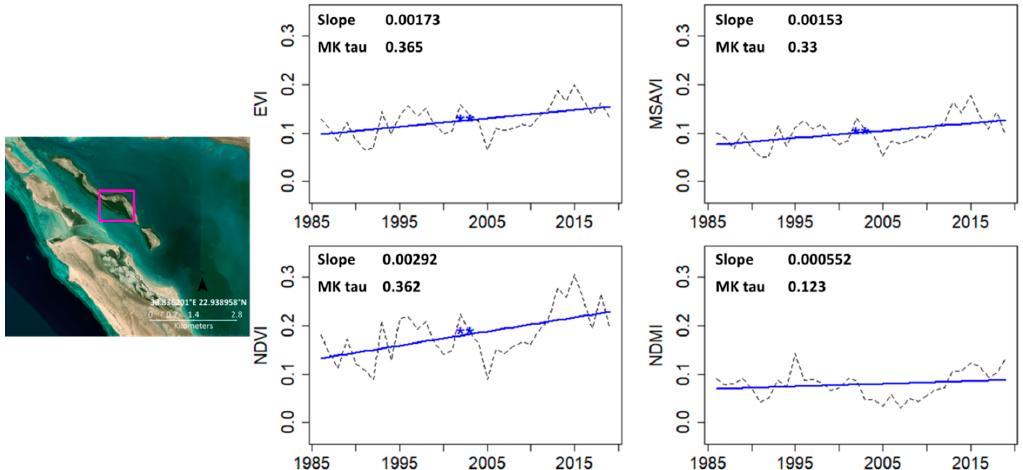
Figure 13. Trend (blue line) analysis for site in the north (enclosed in pink box). The symbol * shows the trend is significant, with two * meaning p value of equal or less than 0.001.